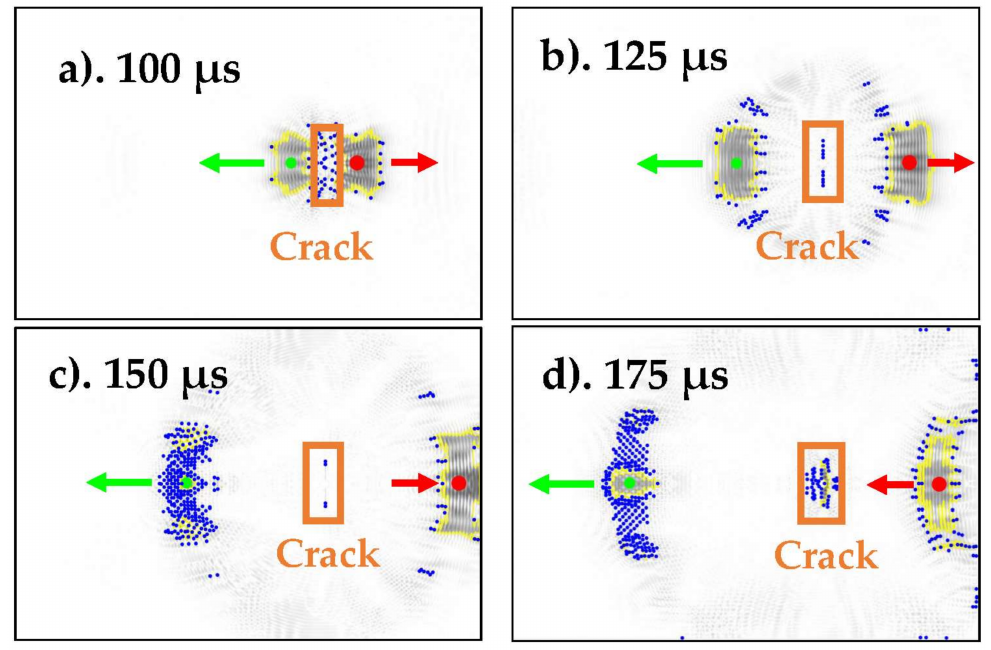
Figure 6. Detected blobs at ( a ) 100 µ s, ( b ) 125 µ s, ( c ) 150 µ s, and ( d ) 175 µ s. The largest and second-largest blobs are marked in red and green, respectively. Arrows indicate the direction of movement of the blobs.